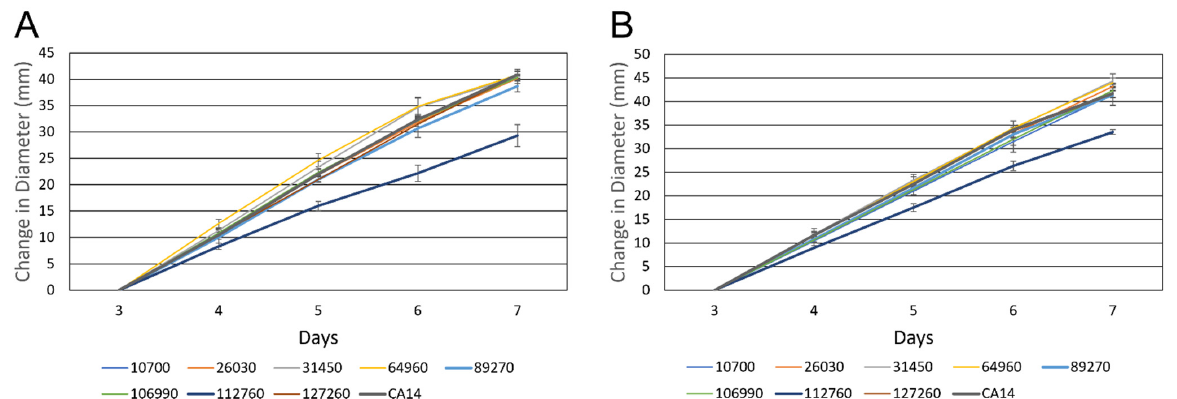
Figure 2. Growth curves of the A. flavus transcription factor knockout strains on ( A ) YGT medium and ( B ) PDA medium. Radial growth over 5 days (starting on day 3) was measured for each of the transcription factor knockout strains. All strains exhibit similar growth rates relative to the control CA14 strain except AFLA_112760, which exhibited decreased growth rates relative to the control strain. Error bars represent the standard deviation.